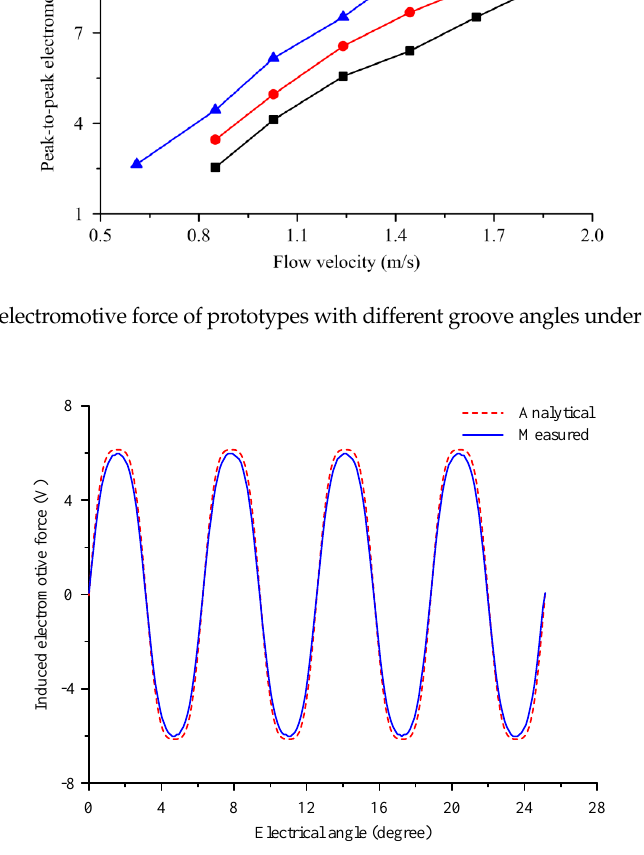
Figure 10. Measured and analytical waveforms of induced electromotive force at rotation speed of 500 rpm.